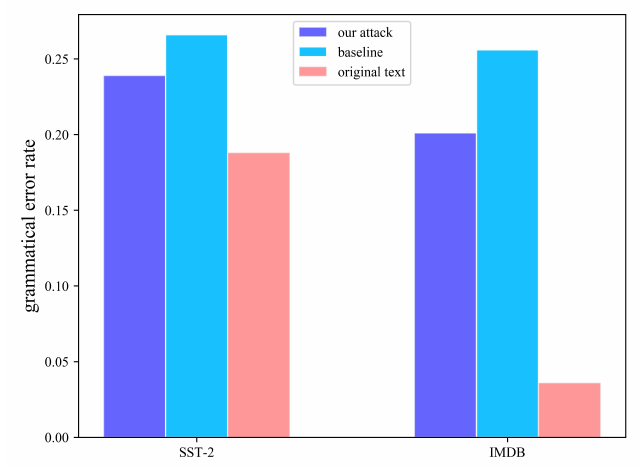
Figure 7. Grammatical error rate in triggers and benign text as the grammar checkers—Grammarly (https://www.grammarly.com) (accessed on 10 October 2021).